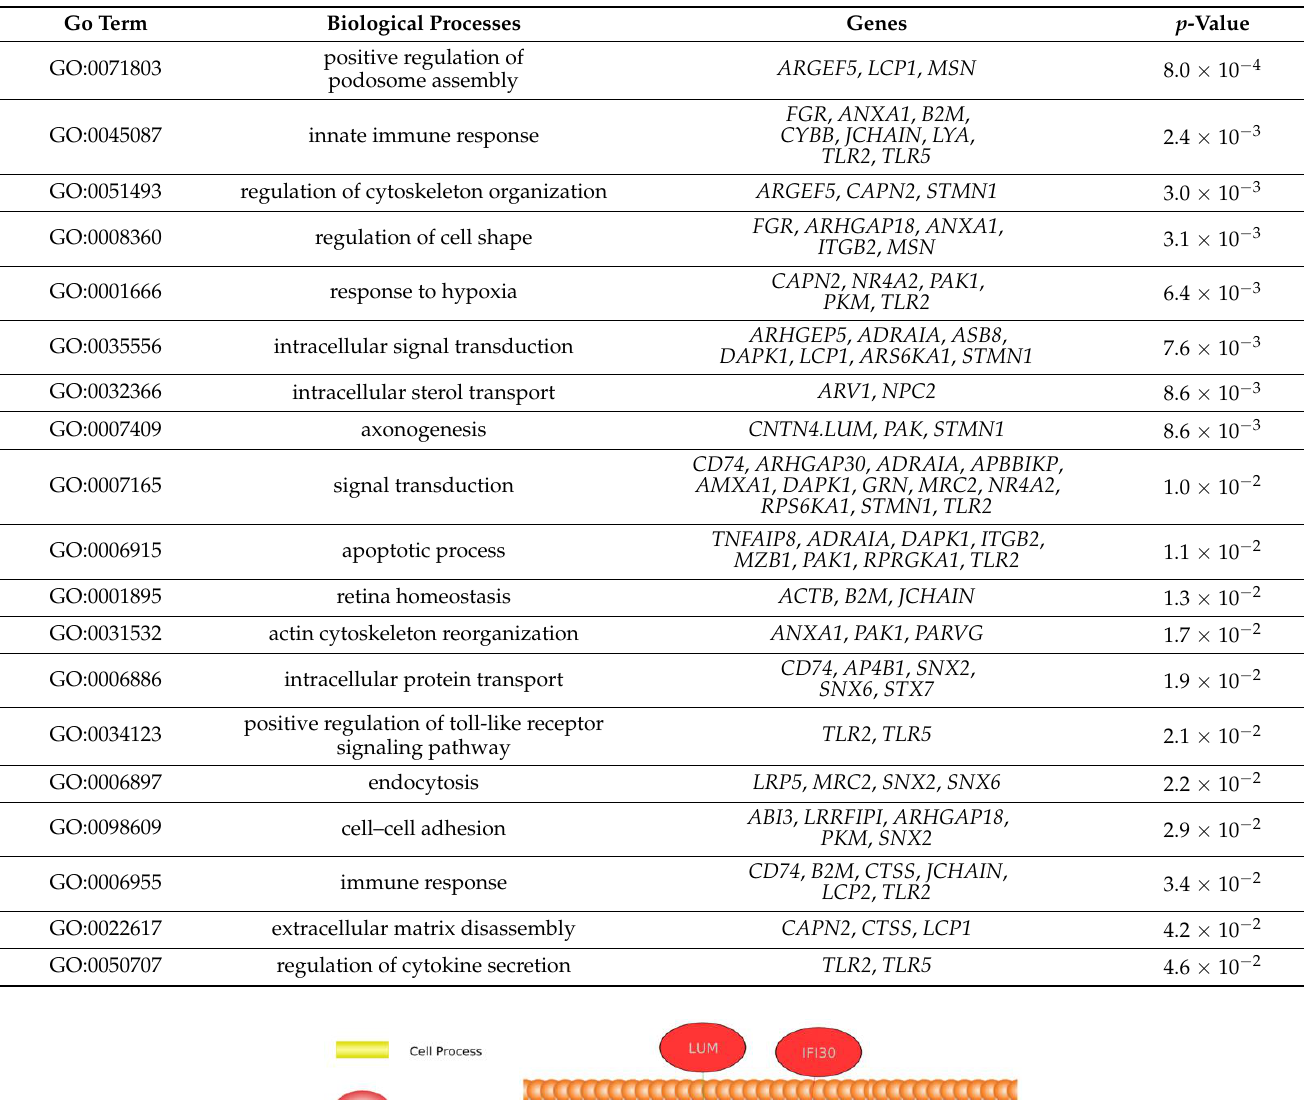
Table 1. The biological processes based on an enrichment p -value ≤ 0.05 involving the 88 genes detected between both genetic groups.